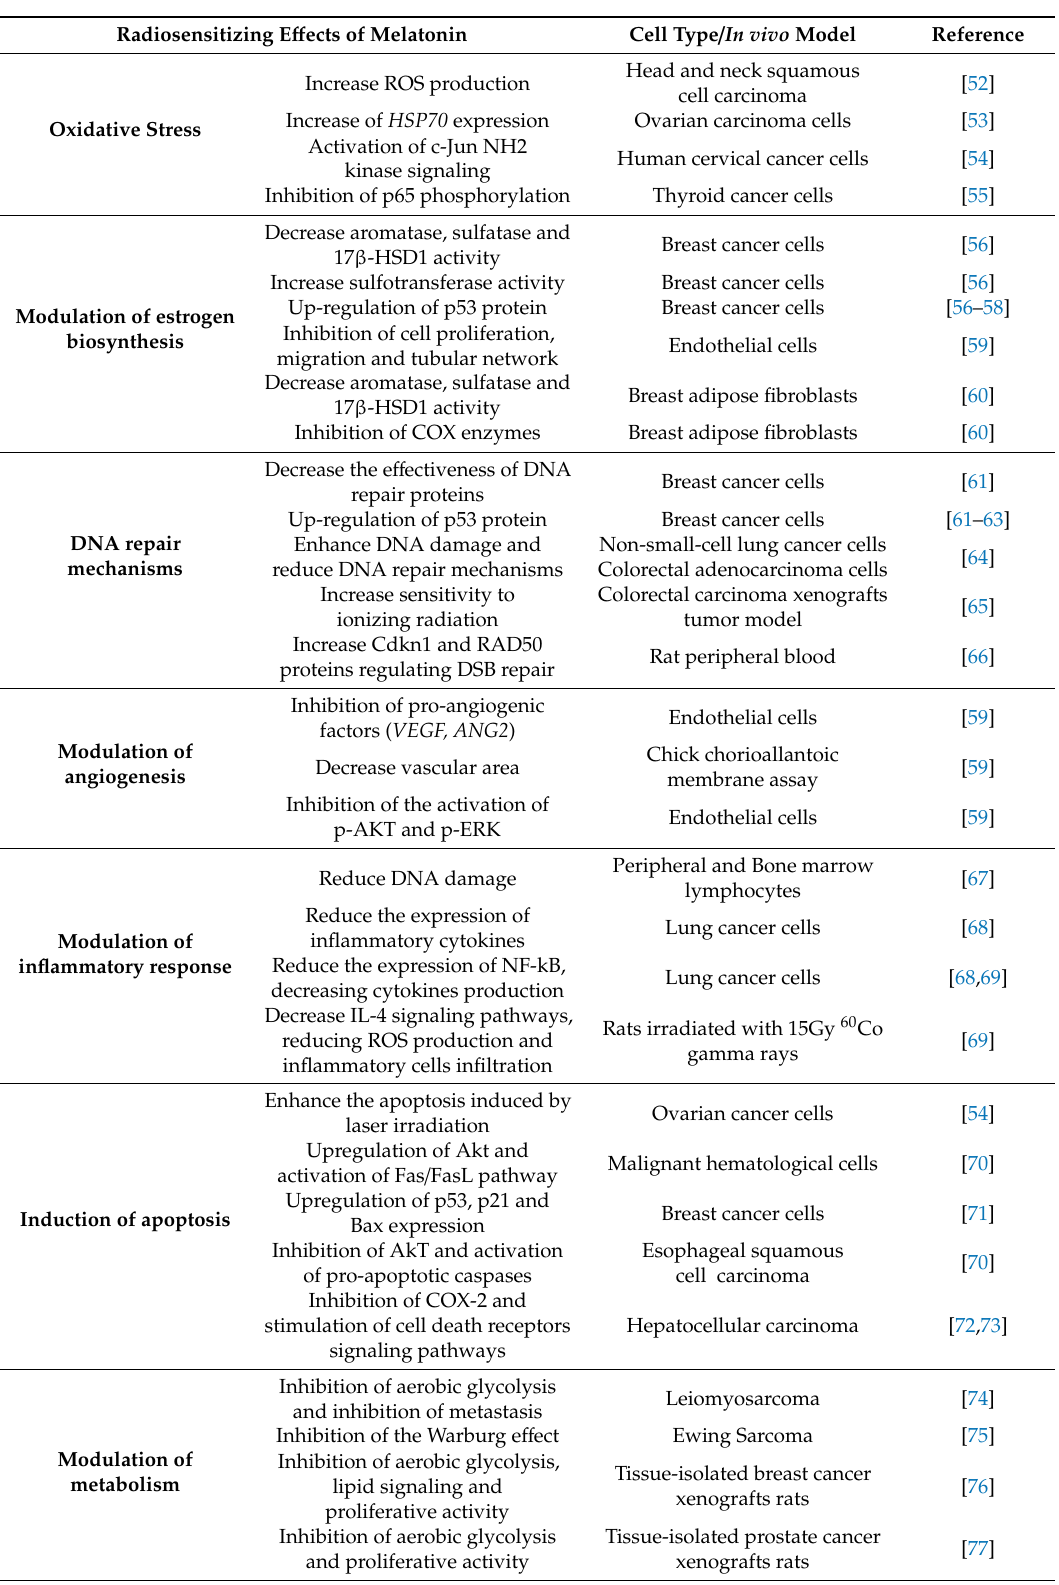
Table 1. Mechanisms of melatonin radiosensitizing e ff